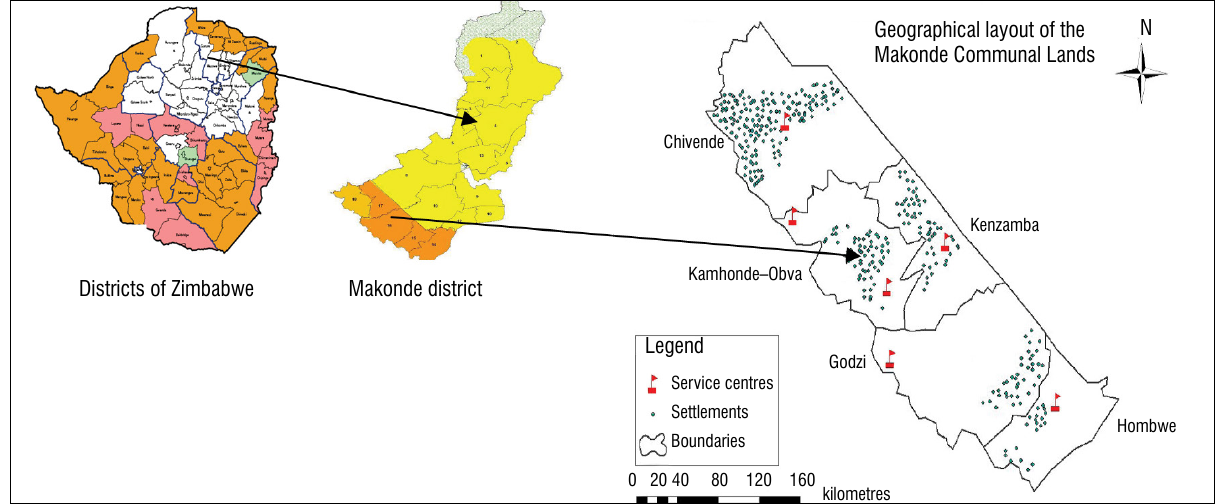
Geographical location of the Makonde Communal Lands within the Makonde Rural District of